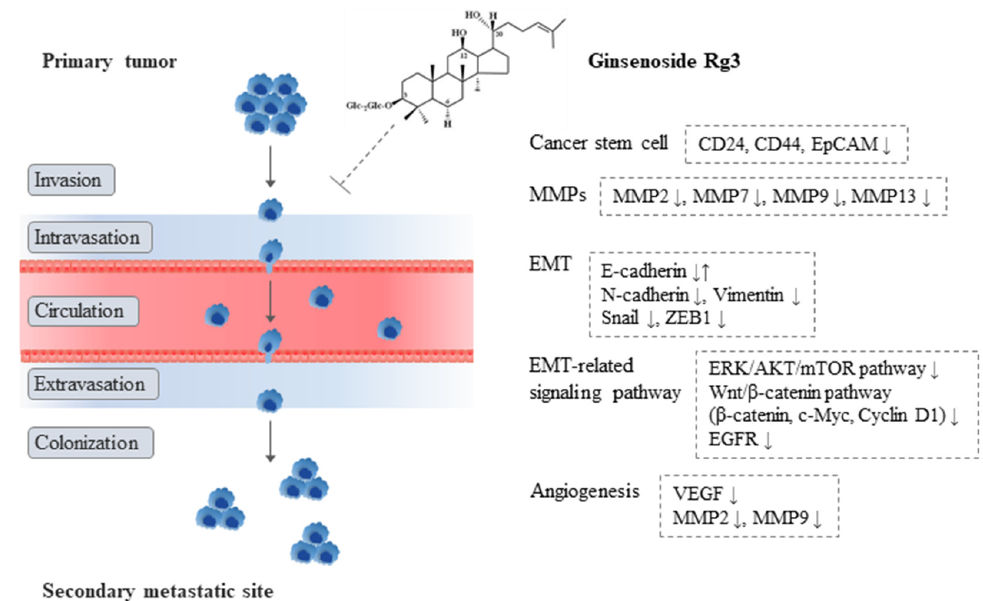
Figure 2. Anti-metastatic actions of ginsenoside Rg3.